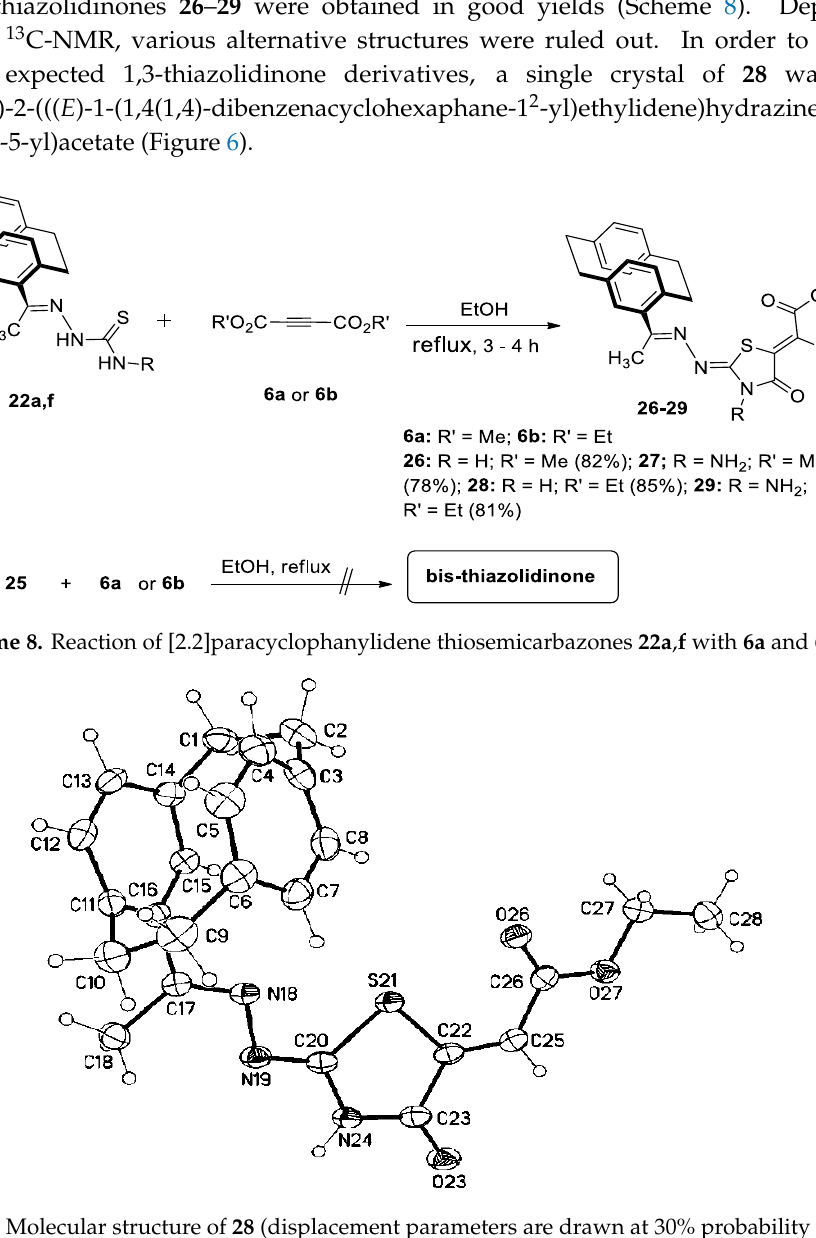
Figure 6. Molecular structure of 28 (displacement parameters are drawn at 30% probability level).